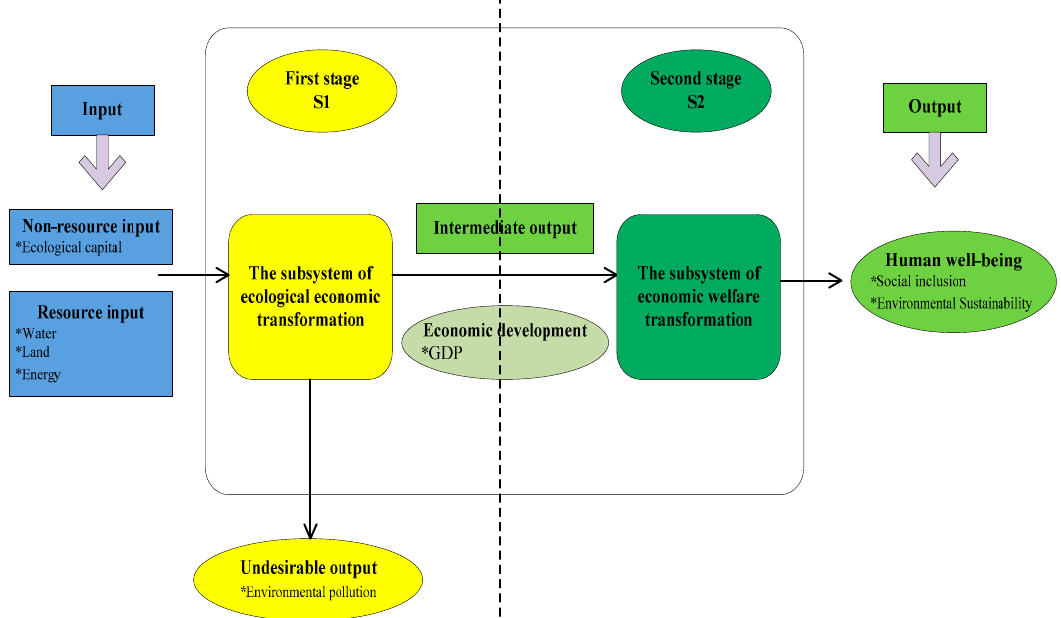
Figure 1. EWP input and output dimensions.